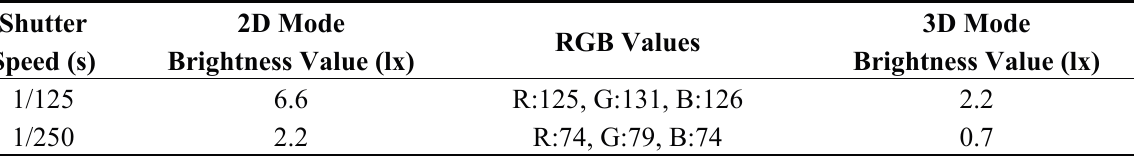
Table 7. F5.6 aperture experimental results.